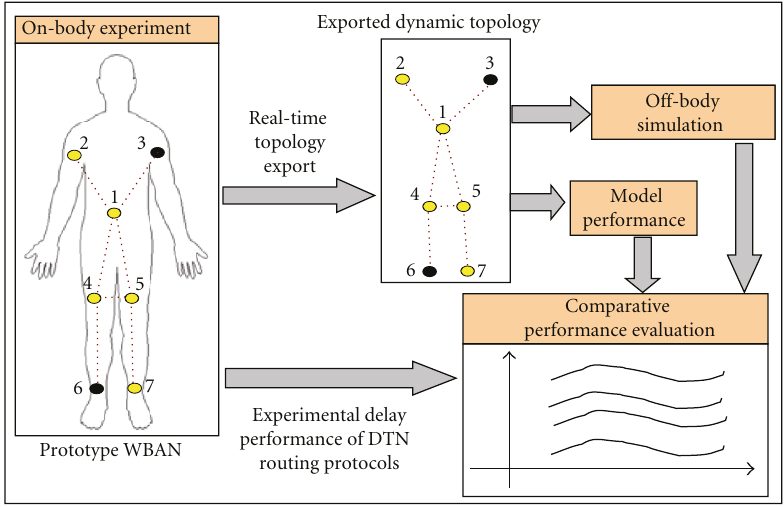
Figure 4: Topology export for o ffl ine and model performance.